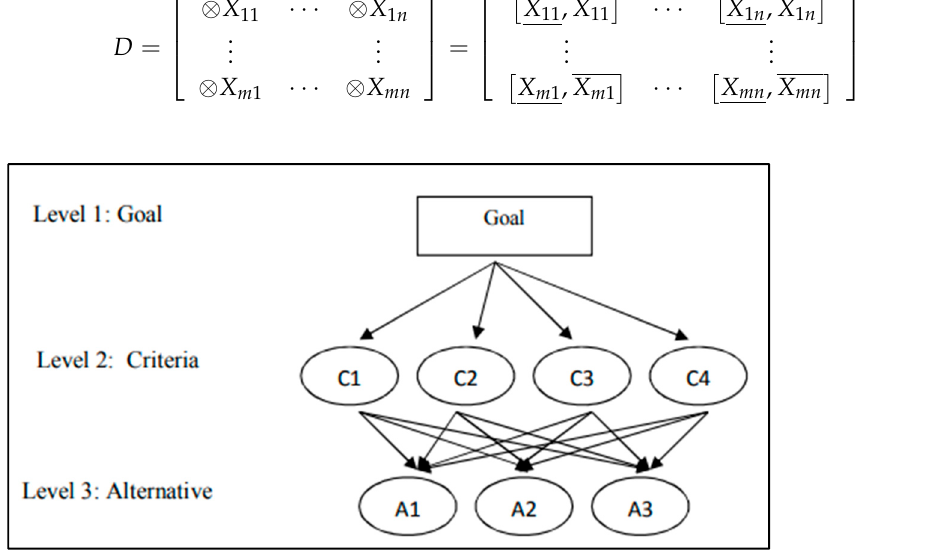
Figure 3. Hierarchy of decisions.